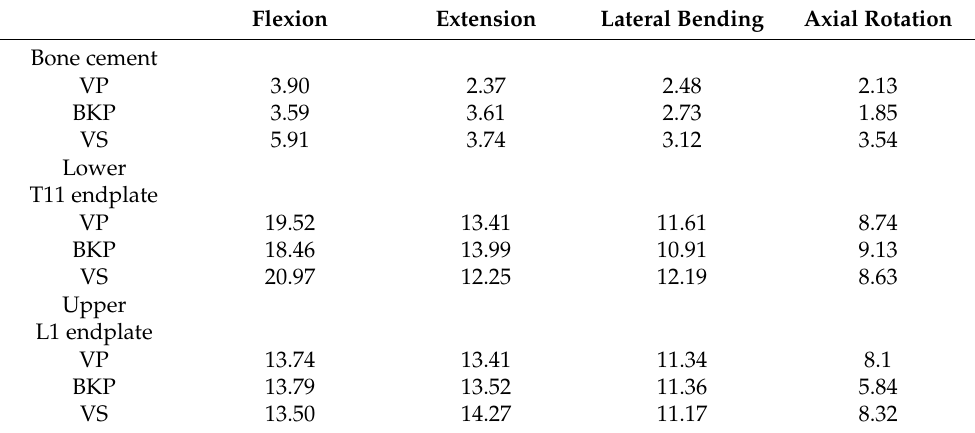
Figure 7. Force-displacement curve of the treated vertebrae after three different surgical procedures. Table 2 summarizes the maximal stress on the T12 cement surface, T11 lower endplate and L1 upper endplate in these three models. Table 2. Maximum von Mises stresses of the three surgical models